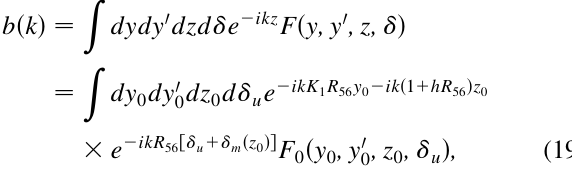
compressed modulation wavelength (cid:9) m =C appear, i.e.,